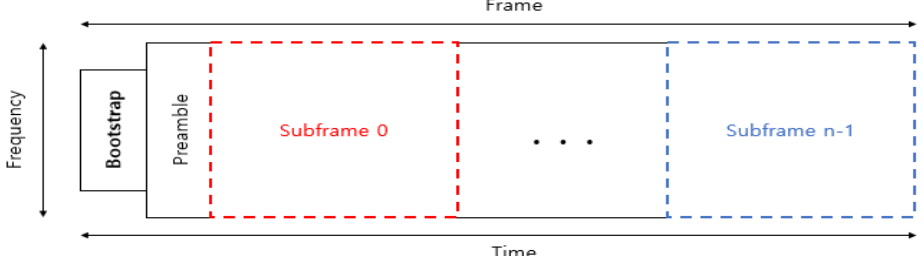
Figure 5. The structure of the physical layer frame in ATSC 3.0.